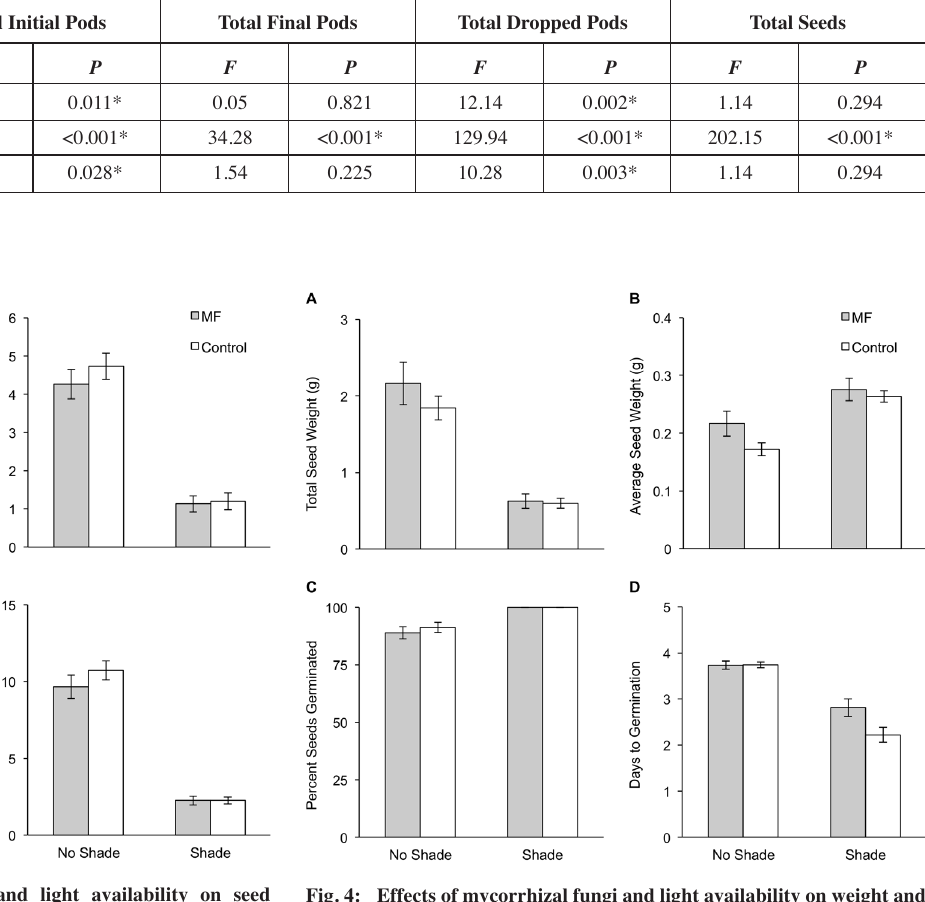
Fig. 4: Effects of mycorrhizal fungi and light availability on weight and viability of seeds. Total weight of seeds per plant (a) and